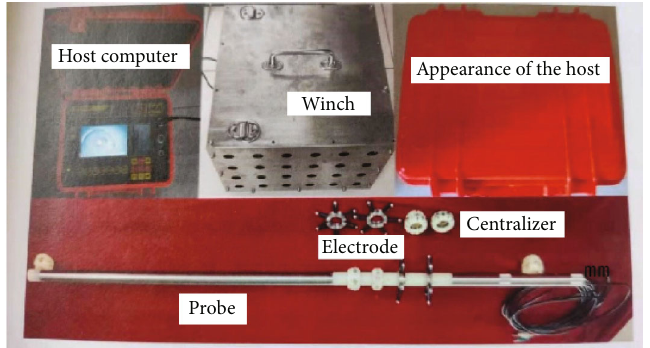
Figure 4: YZD18.5 mine lateral resistivity video imaging logging